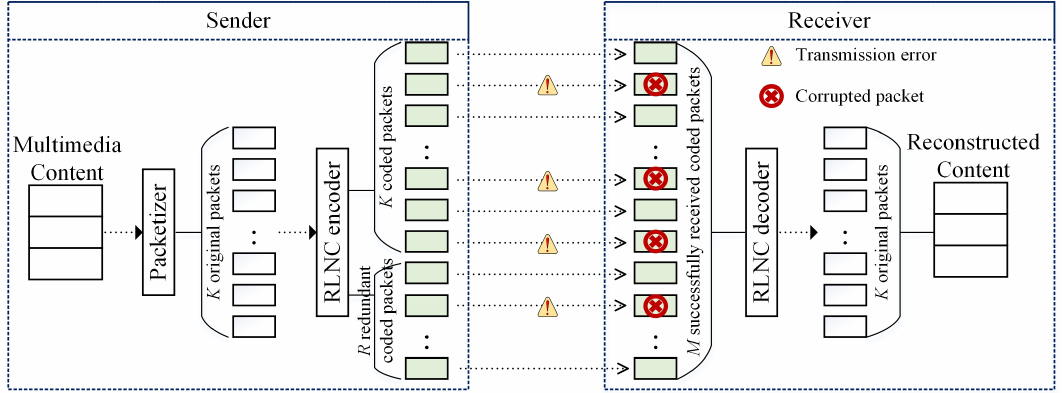
Figure 1. Redundancy mechanism using